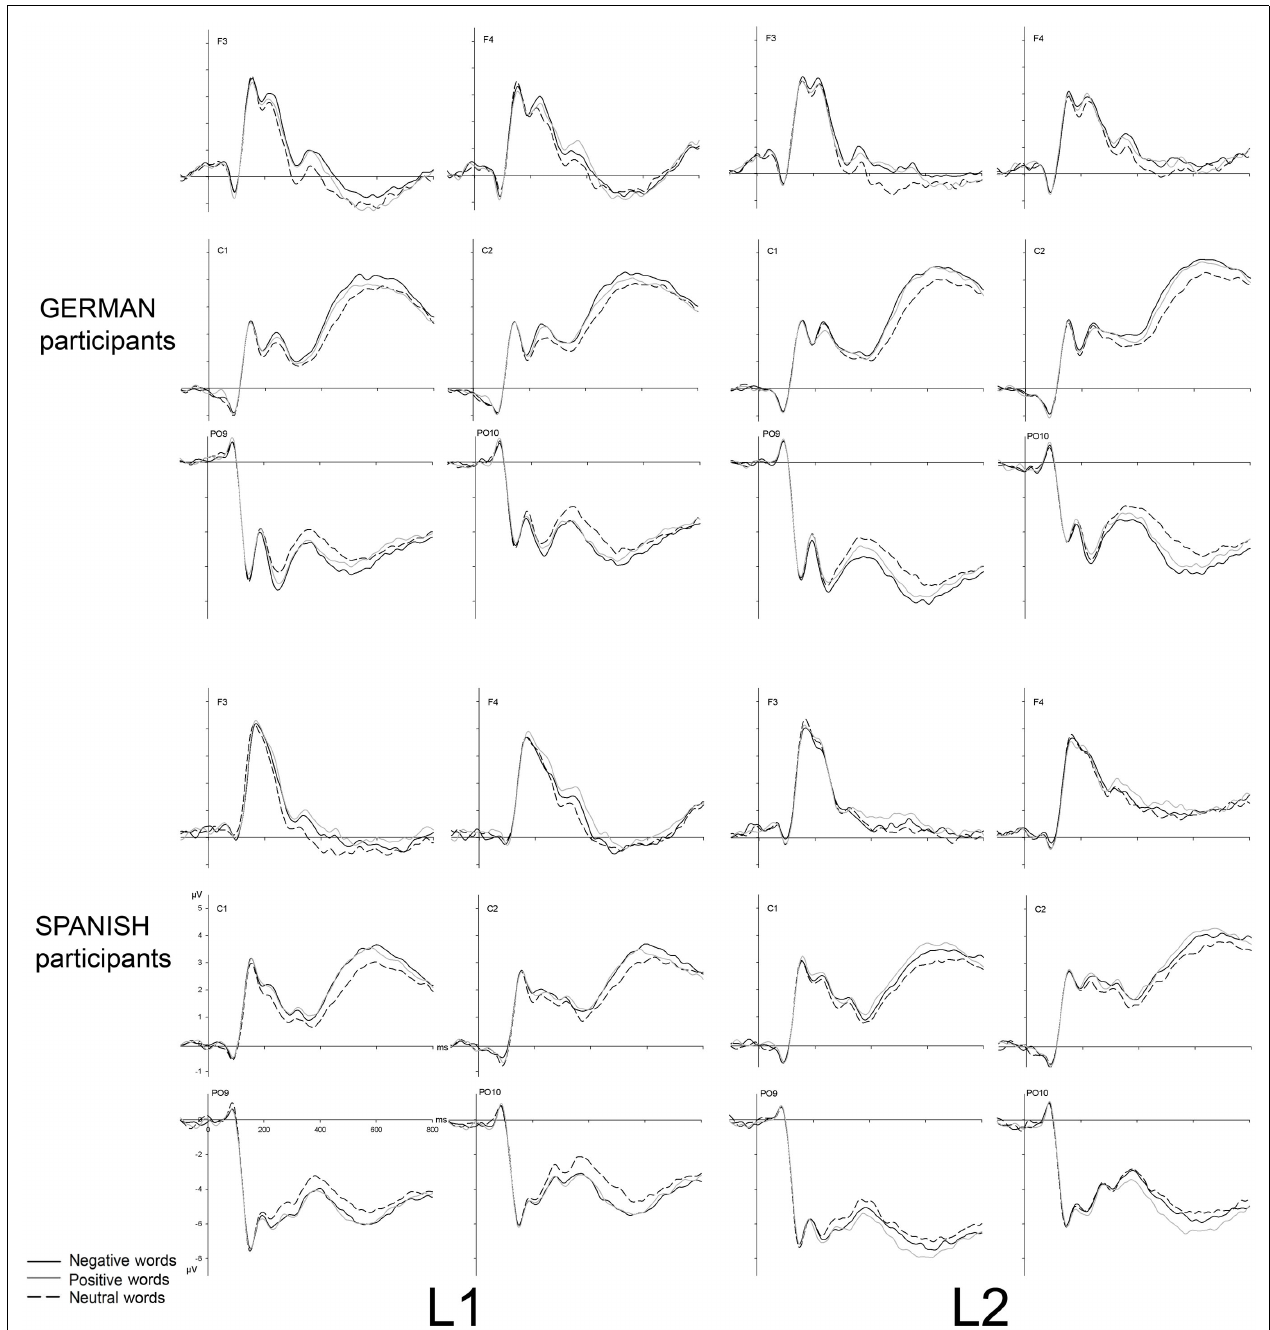
FIGURE 2 | Mean activity for words with different valence (positive, negative, neutral) in first (L1) or second (L2) language for 40 German and 26 Spanish participants on electrode sites F3, F4, C1, C2, PO9, and PO10.